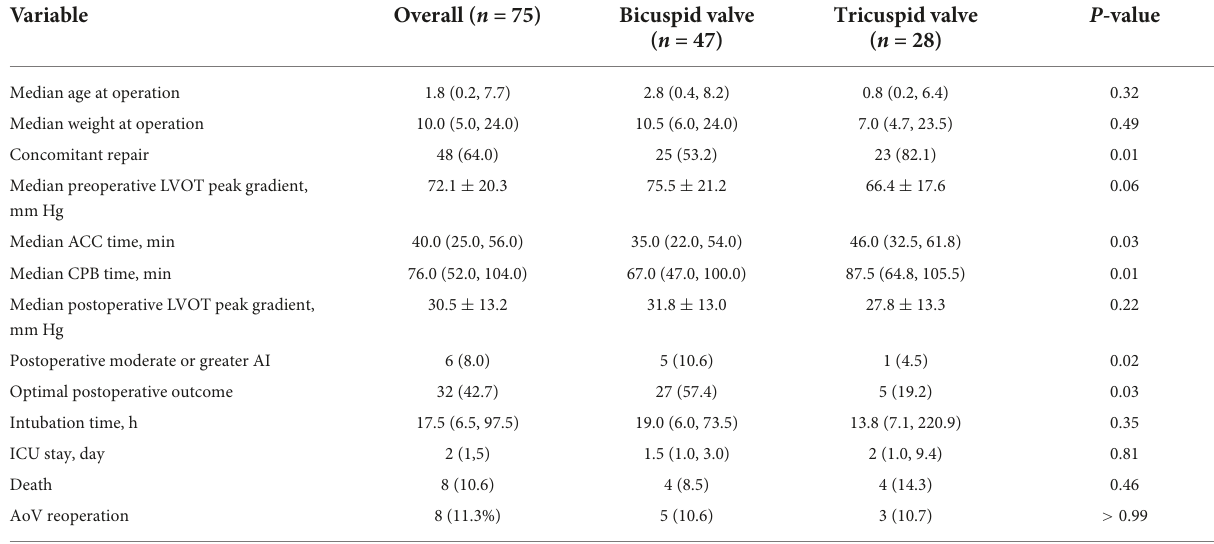
TABLE 2 Baseline characteristics.